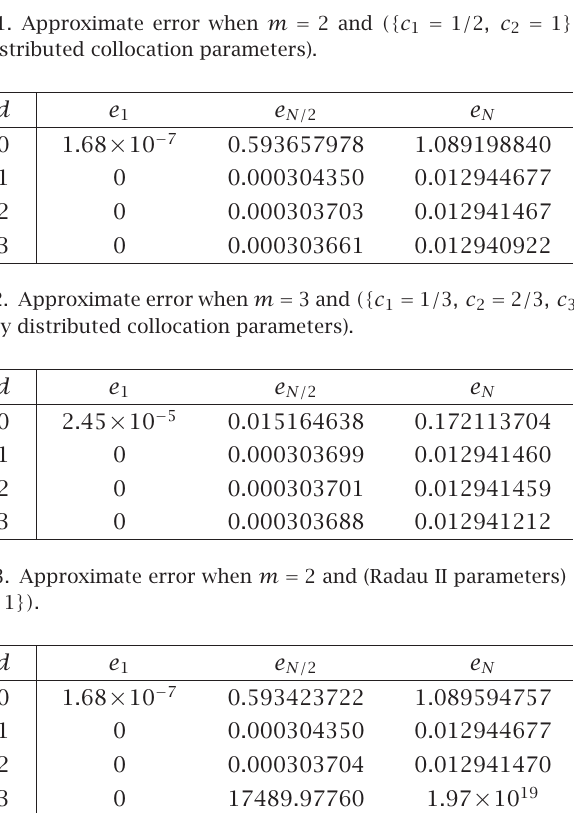
= 1 / 2 , c = 1 } ) (uni- 1 2